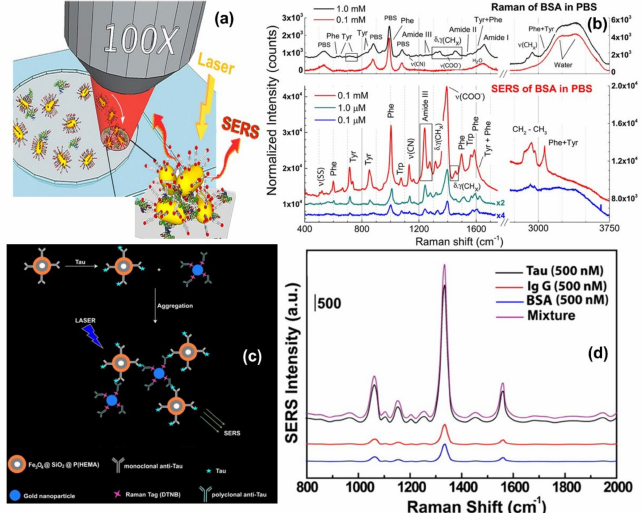
Figure 6. Panel ( a ) shows the schematic of the principle of SERS detection of biomolecules using optical force. Panel ( b ) shows the comparison between Raman spectra and SERS spectra of BSA and Phenylalanine in phosphate buffer solution. Reproduced with permission from Springer Nature Publications of ref. [67]. Panel ( c , d ) are the schematic of the experimental procedure of indirect protein sensing platform and the SERS spectra of monoclonal anti-tau functionalized hybrid nanoparticles exposed to BSA (500 nM), IgG (500 nM), tau (500 nM), and a solution with equal amounts (500 nM) of BSA, IgG, and tau. Reprinted (adapted) with permission from ref. [114], Copyright 2013 American Chemical